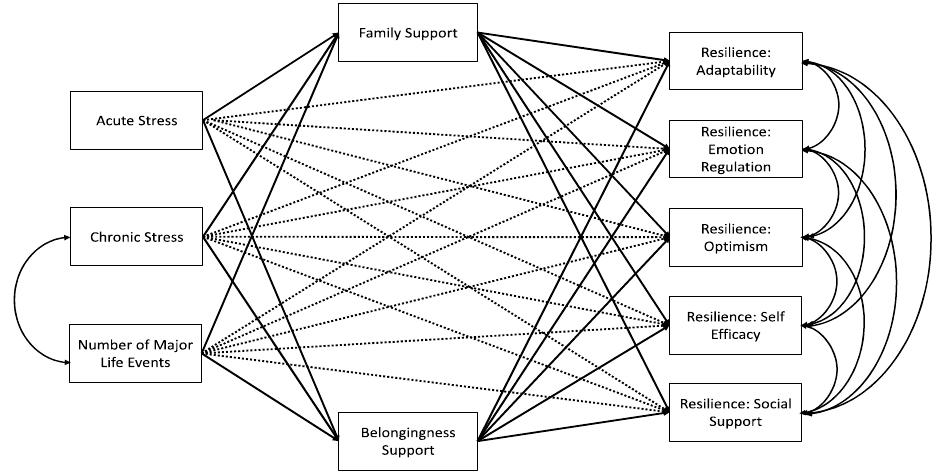
Figure 1. Original path analysis model examining family support and belongingness support as mediators of the relationship between chronic stress and resilience and between acute stress and resilience.